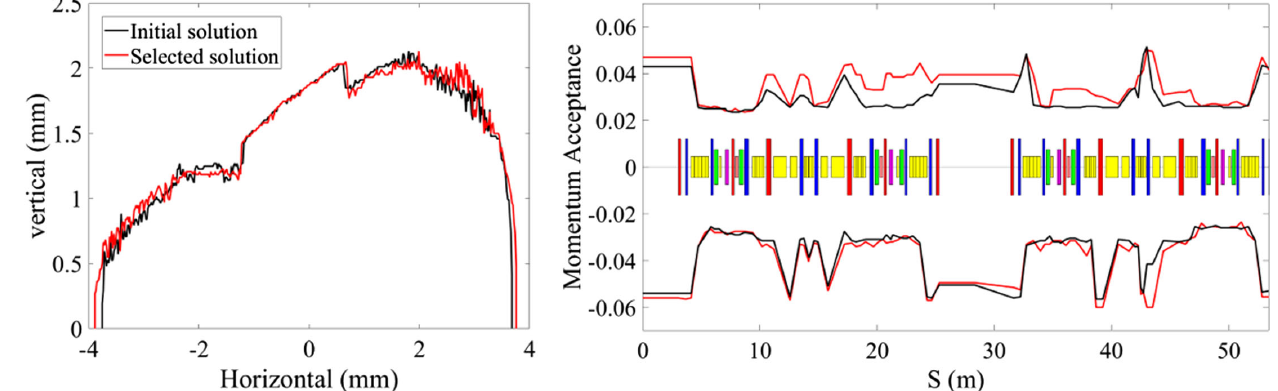
FIG. 13. The numerical tracking results of the DA (left) and local momentum acceptance (right) for the initial solution (black curve) and the selected solution (red curve).